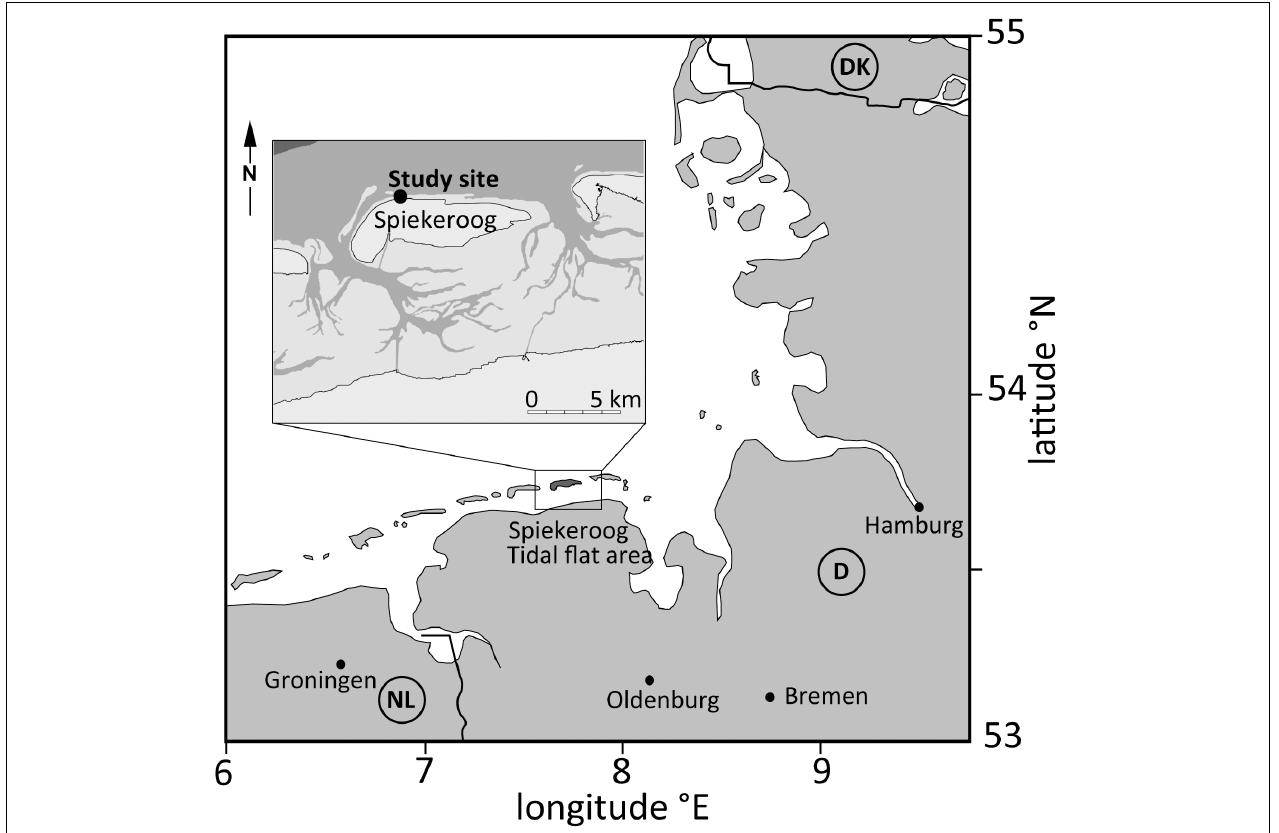
FIGURE 1 | Sampling area on Spiekeroog Island, North